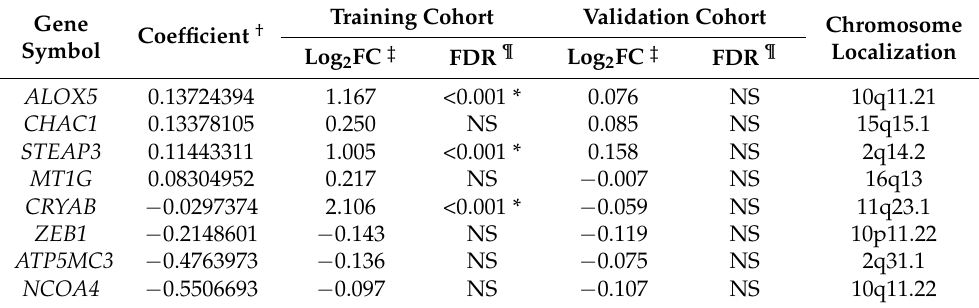
Table 1. Genes with Log2FC, FDR, and their coefficients in the prognostic model after LASSO